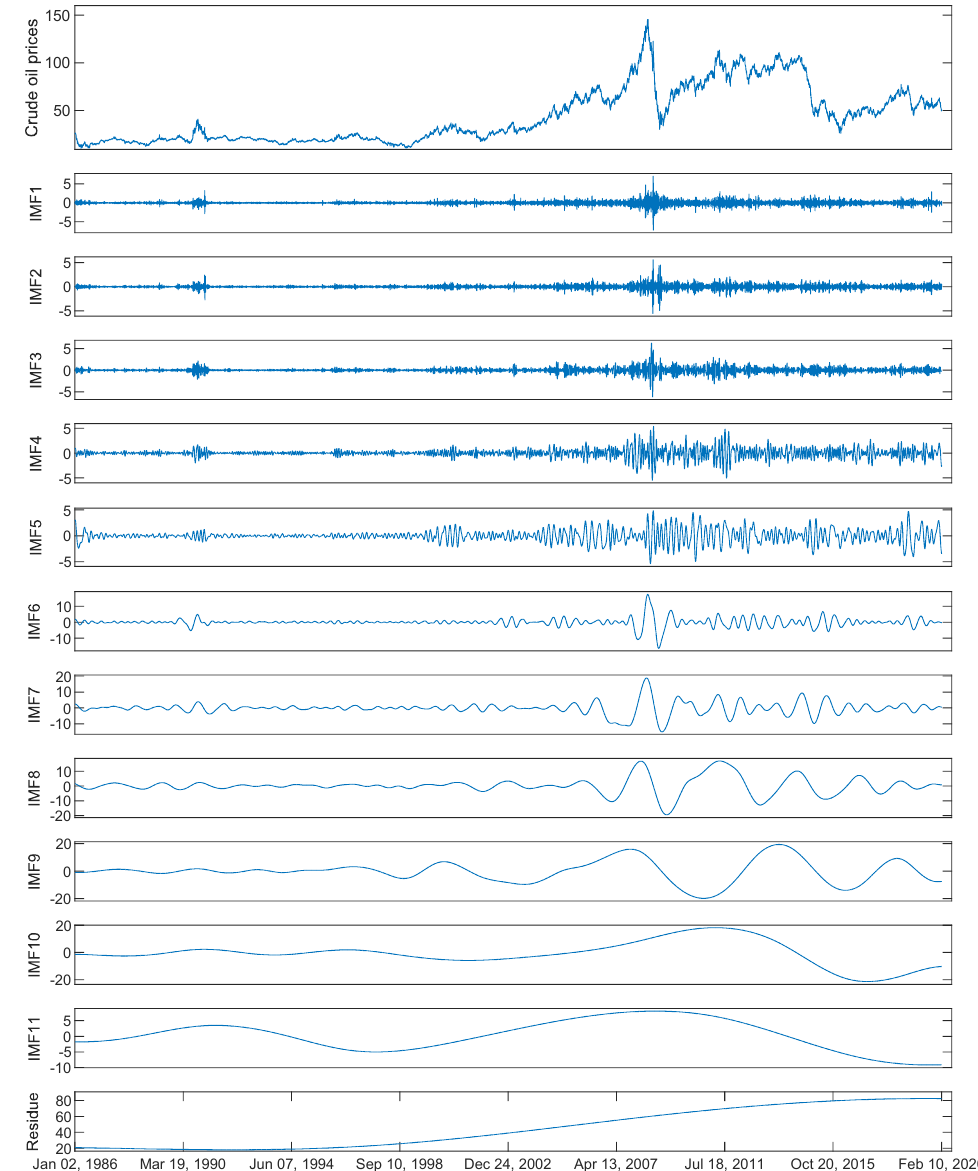
Figure 3. The crude oil prices and the corresponding decomposed components by ICEEMDAN. ICEEMDAN: Improved complete ensemble empirical mode decomposition with adaptive